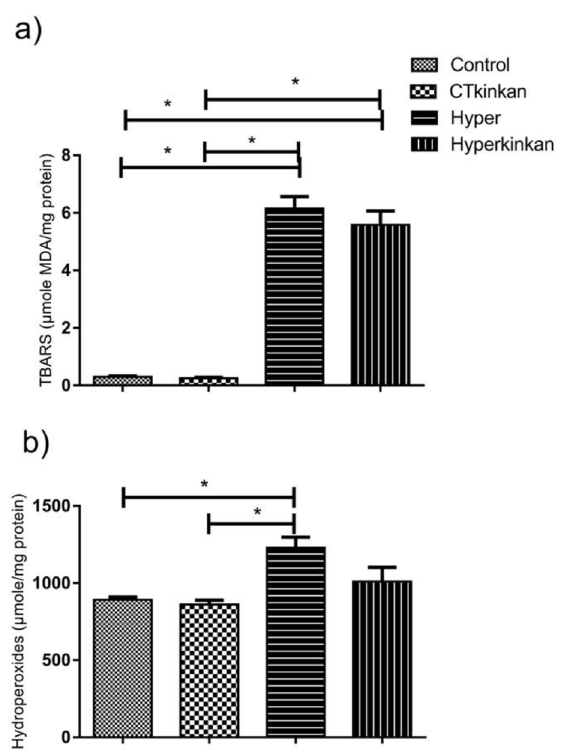
Figure 2. Effect of kinkan orange intake on hepatic (a) TBARS and (b) hydroperoxides levels of rats given Control, CTkinkan, Hyper, and Hyperkinkan diets. The data represents means + SEM of 10 animals per group. *p < 0.05. *Bars represent statistical significance, p < 0.05, using two-way ANOVA followed by post hoc Bonferroni